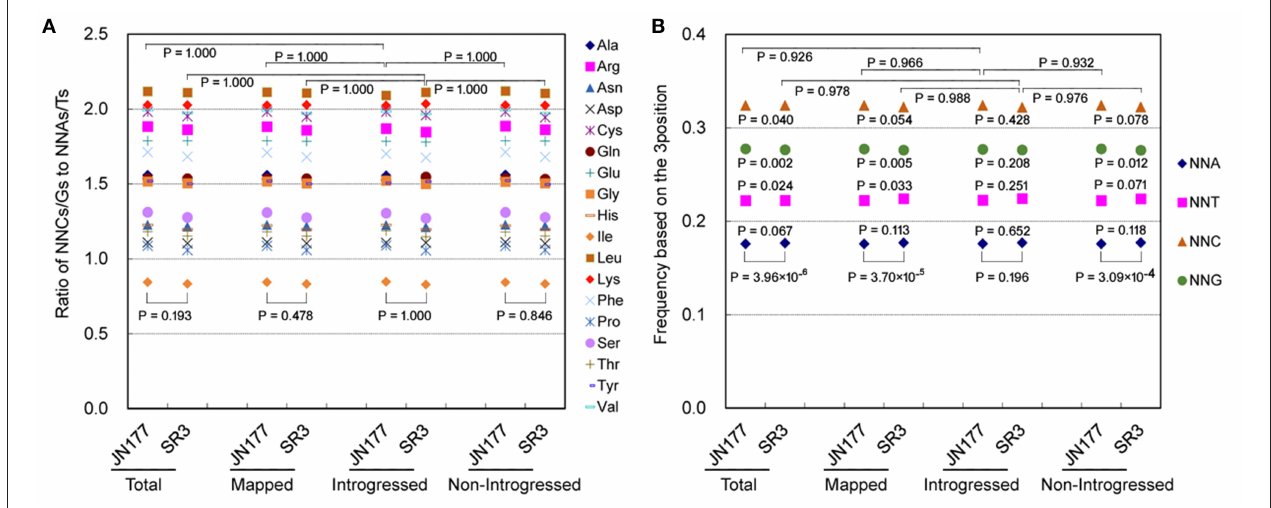
FIGURE 2 | SCUB was shifted to a similar extent in chromosomes introgressed with and without exogenous fragments. (A) The ratios of the frequencies of NNC/NNG SCs to NNA/NNT SCs. NNCs/Gs: SCs with C or G as their final bases; NNAs/Ts: SCs with A or T as their final base. (B) The total frequency of NNA, NNT, NNC, and NNG codons. The total frequency was calculated as the ratio between the number of all SCs ending with A, T, C, or G and the amount of all SCs. Total: all unigenes; Mapped: unigenes mapped to chromosomes; Introgressed: unigenes from chromosomes introgressed with exogenous fragments; Non-introgresed: unigenes from chromosomes without exogenous fragments. The statistical comparison was conducted with chi square ( χ 2 ) test of fourfold cross-table